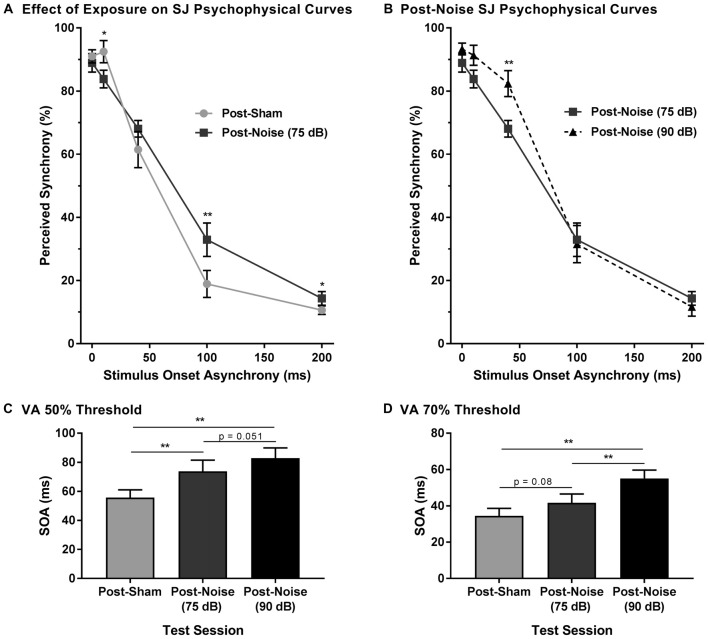
Impaired audiovisual synchrony perception following adult-onset hearing loss. (A) Experimental test sessions for the SJ task at 75 dB SPL were completed 2 weeks following exposure to a loud noise (i.e., post-noise) or quiet (post-sham). (B) An additional test session was completed at 90 dB SPL (i.e., post-noise (90 dB SPL)) and compared to the test session at 75 dB SPL (i.e., post-noise (75 dB SPL)), in order to determine if synchrony perception remained sensitive to sound intensity (*p < 0.05, **p < 0.01). For all test sessions, performance was plotted as the proportion of trials that the rats perceived as “synchronous” (i.e., responded to the left feeder trough). The (C) 50% threshold and (D) 70% threshold were derived from all SJ test sessions. Two weeks following noise exposure, there was a significant increase in the 50% threshold (**p < 0.017), and a modest increase in the 70% threshold (p = 0.08), indicative of a wider window of perceptual binding. Results are displayed as mean ± SEM, n = 9.